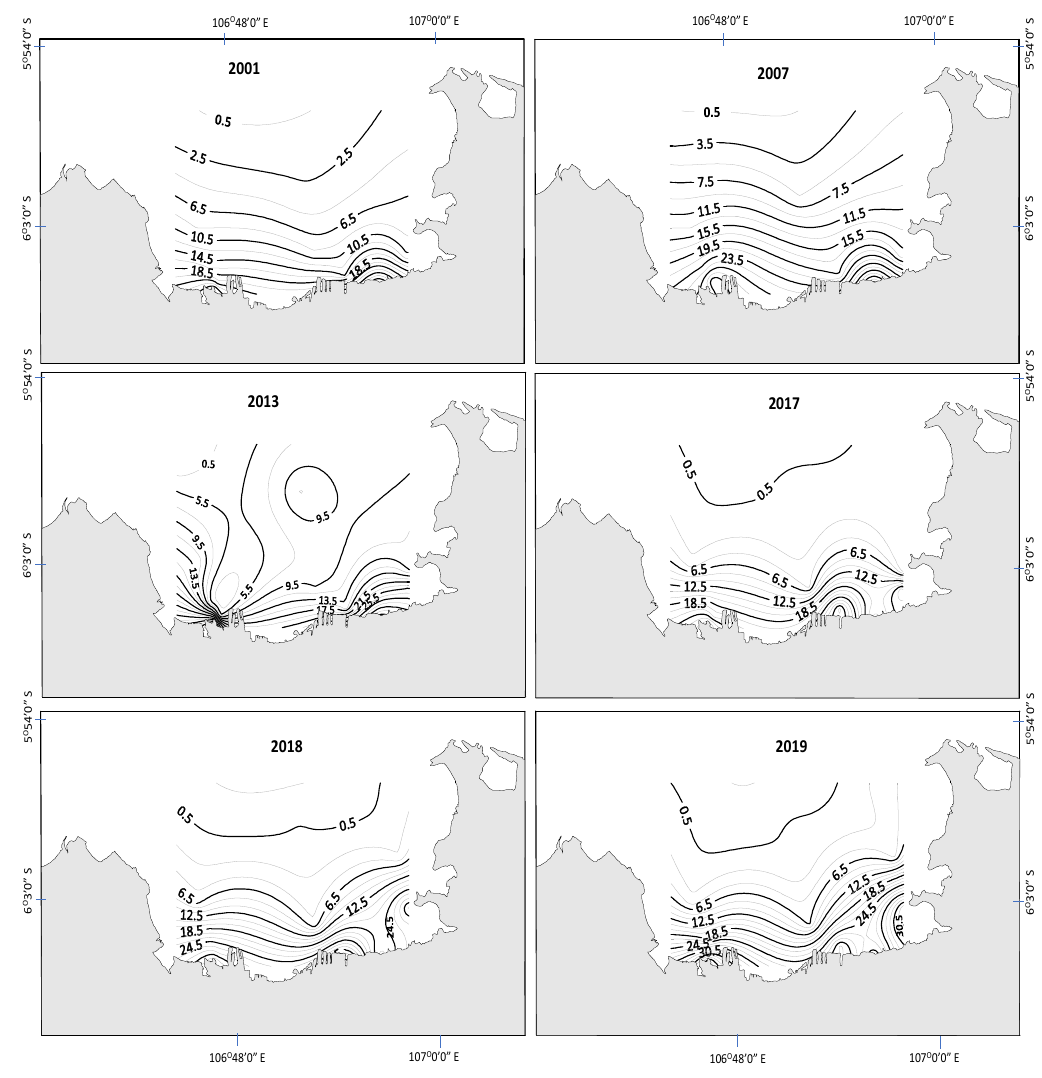
− 1 ) in Jakarta Bay.